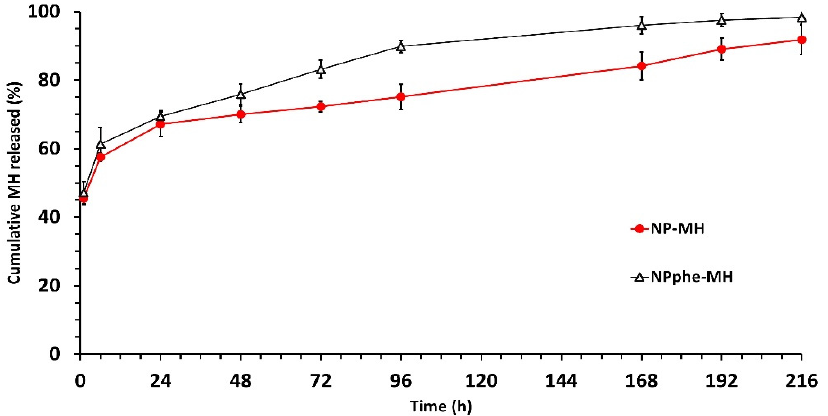
Figure 3. Mean in vitro release profiles ( ± SD) of MH from formulations NP-MH and NPphe-MH. MH: Morin hydrate; phe: Phenylalanine.